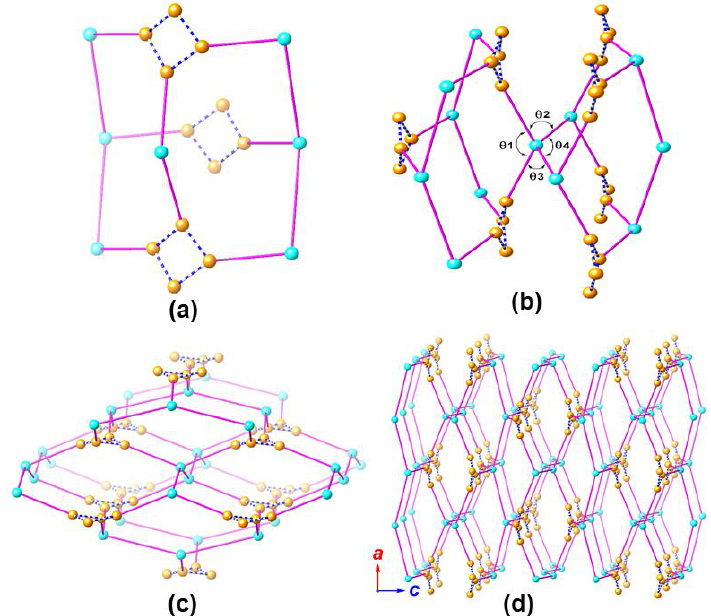
Figure 6. Topological presentations of MOF 1 , with the [Cd 2 Ca] subunits (Cd1-Ca1-Cd2) presented as orange spheres, and Ca2 ions that mediate the association of the V-shaped heptanuclear cluster and 1D rod-shaped chain presented as cyan spheres. The [Cd 2 Ca] subunits (Cd3-Ca3-Cd3) within the 1D rod-shaped subunits have no topological contribution and are thus omitted. A set of four [Cd 2 Ca] subunits (Cd1-Ca1-Cd2) are spatially clustered and they are grouped using dashed lines to facilitate topological understanding. These subunits function either as the edge ([Cd 2 Ca] cluster within the 1D rod-shaped chain), or the vertices (Ca2 or four [Cd 2 Ca] clusters of the heptanuclear subunits that collectively serve as one vertex) in a diamondoid network. Figure ( a ) shows a repeating unit of the diamondoid network, i.e., an adamantane unit consisting of 10 vertices, while ( b ) depicts two vertex-shared adamantane units. Figure ( c , d ) show the diamondoid network looking along the crystallographic b axis, with ( c ) also elucidating connections among these clusters.